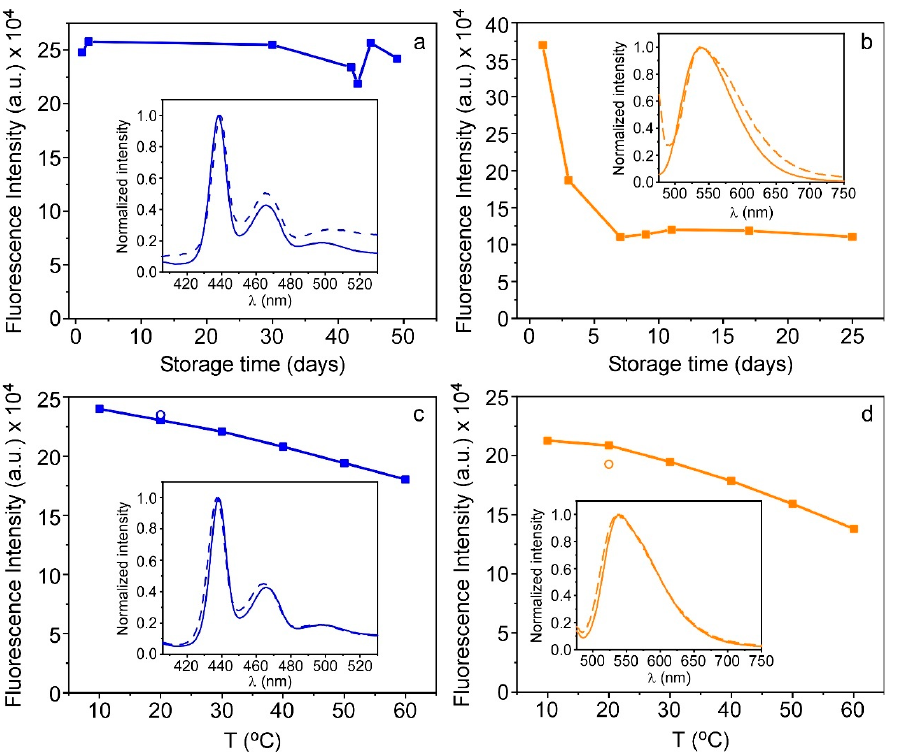
Figure 5. Effect of storage time and temperature on the stability of freshly prepared PFO@AETA ( a , c ) and F8BT@AETA ( b , d ) hydrogels measured at the fluorescence intensity maximum. The empty circles in ( c , d ) indicate the fluorescence intensity recovered after the heat treatment. Insets: Normalized fluorescence emission spectra at the first day (solid line) and the last day (dashed line) ( a , b ), and at 10 ◦ C (solid line) and 60 ◦ C (dashed line) ( c , d